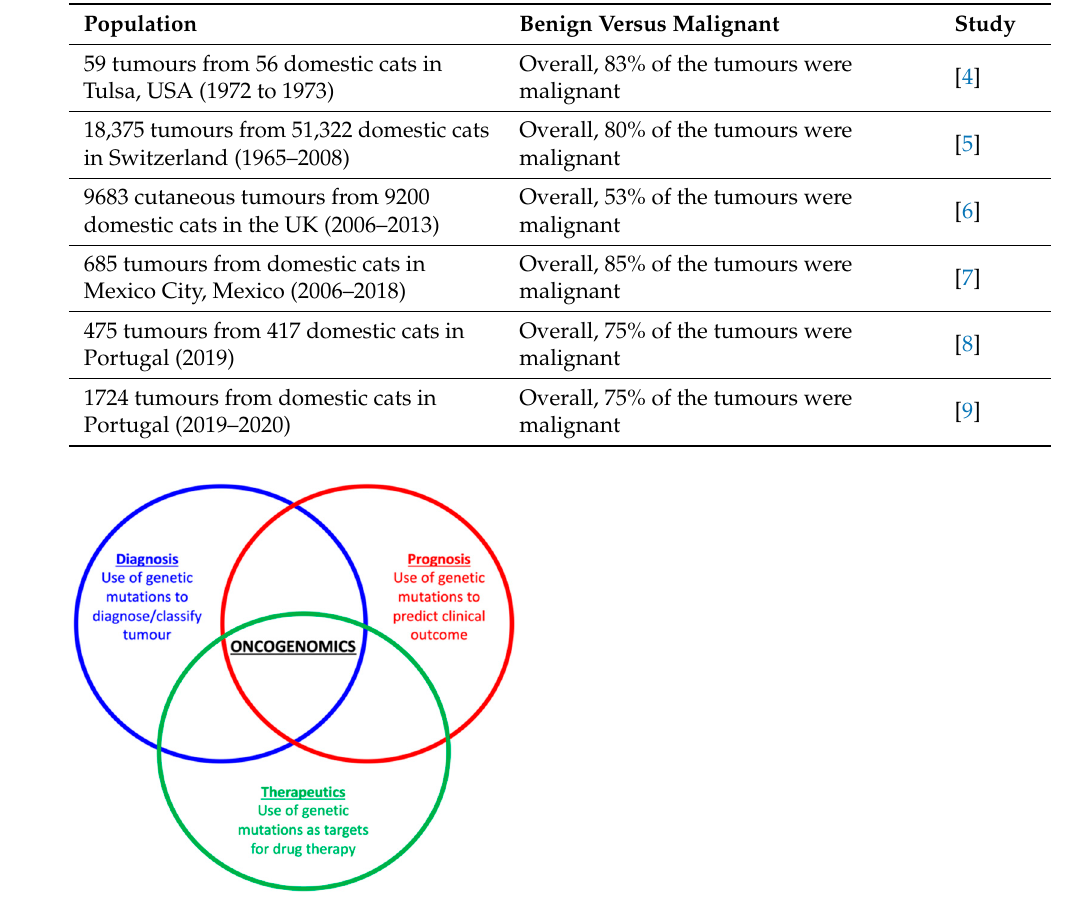
Figure 1. Potential benefits that can come from understanding the feline oncogenome, such as the development of diagnostic tools, prognostic markers and/or targeted therapies.